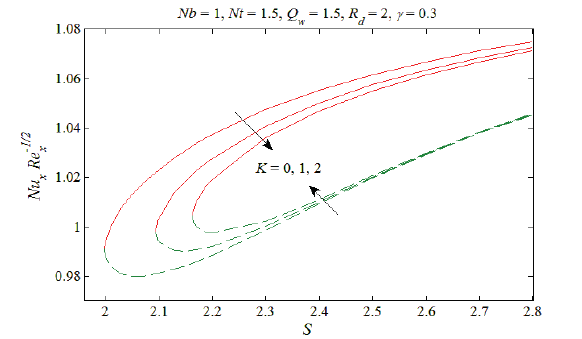
Fig. 13: The Nusselt number Nu x Re −1/2 x versus S for different values of K .